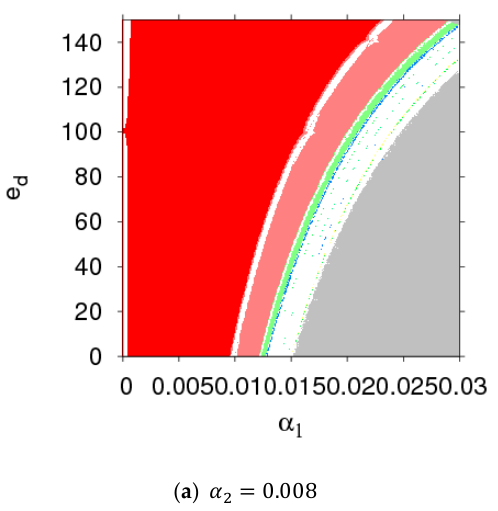
Figure 12. The parameter basins of dynamic System (7) in the planes of (𝛼 1 ,𝜆 1 ) and (𝛼 2 , 𝜆 1 ).